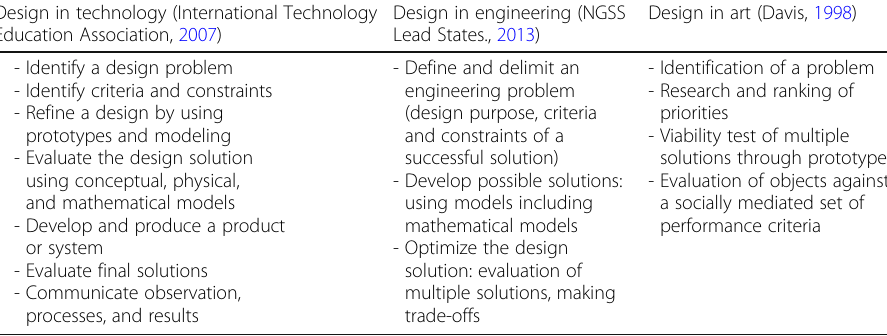
Table 1 Design process in different areas Design in technology (International Technology Education Association, 2007)